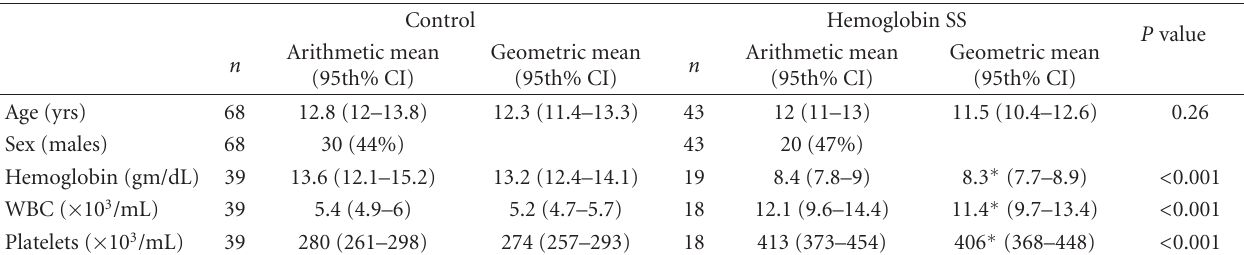
Table 1: Subject characteristics and hematologic parameters. There was no di ff erence in age and sex of the participants in each group.